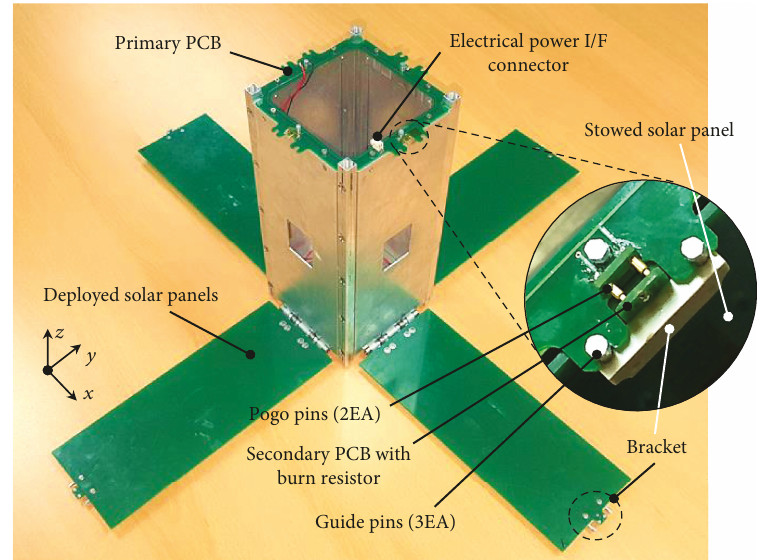
Figure 4: Demonstration model of the pogo pin-type holding and release mechanism.